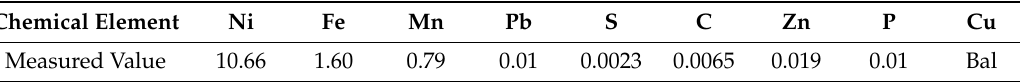
Figure 4. Schematic diagram of welding position. Before this experiment, the control variable method was used to find out the working range of input parameters. The working range was determined by the steady welding procedure and invisible weld defects. In order to obtain optimized welding parameters, the establishment of a test parameter matrix adopts the center composed design (CCD) in the regression design method. In the CCD design, the upper and lower limit values of the input parameters were coded as ± β , the value of β is dependent on the number of input parameters and β =